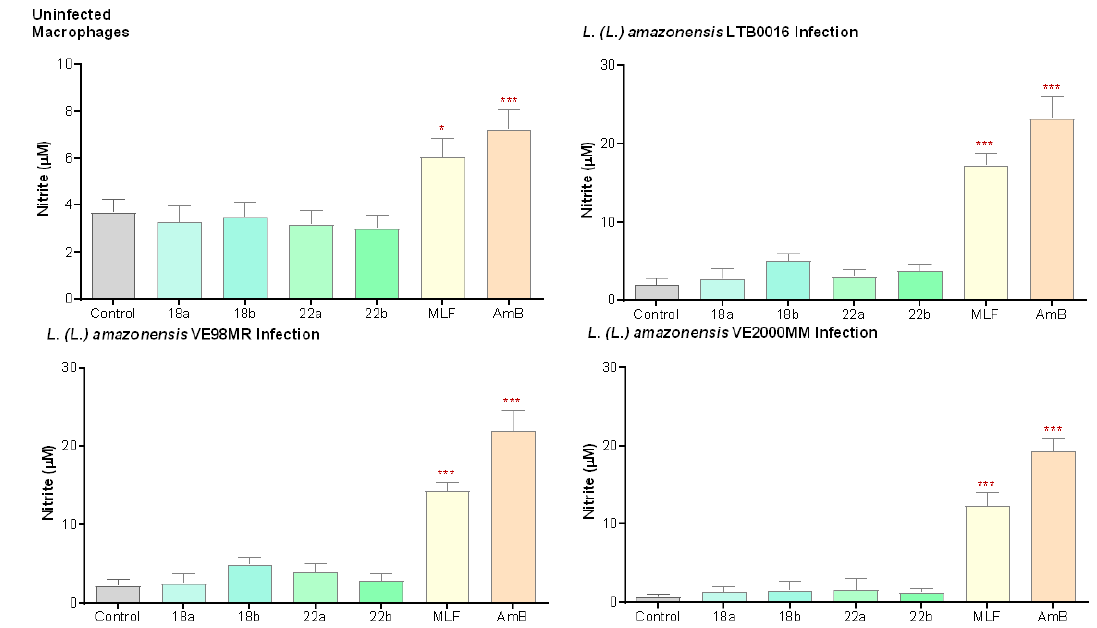
Figure 3. Effect of betulin derivatives on the production of nitric oxide (as µM nitrite) by healthy macrophages or macrophages infected either with LTB0016, 98MR, or VE2000MM, at two increasing concentrations (a and b): 18 (1 and 2 µM), 22 (2 and 4 µM), incubated for 48 h. Each bar represents the average ( n = 3 independent experiments) with its